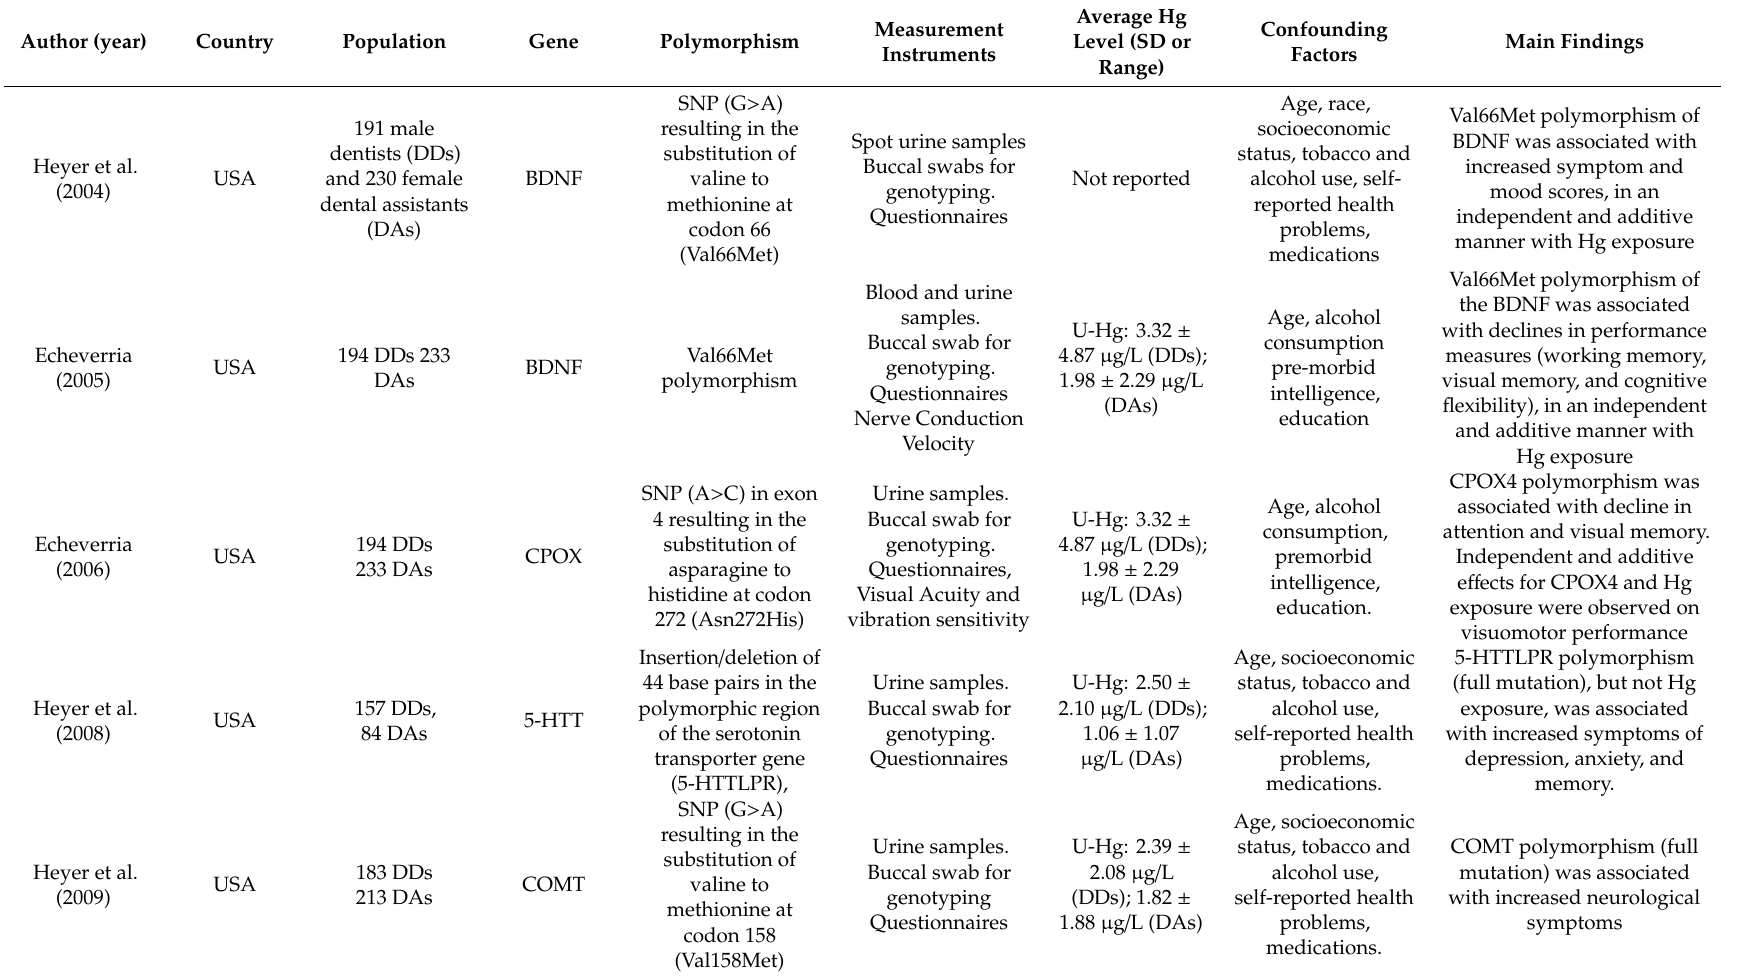
Table 1. Description of the studies included in the review (n =